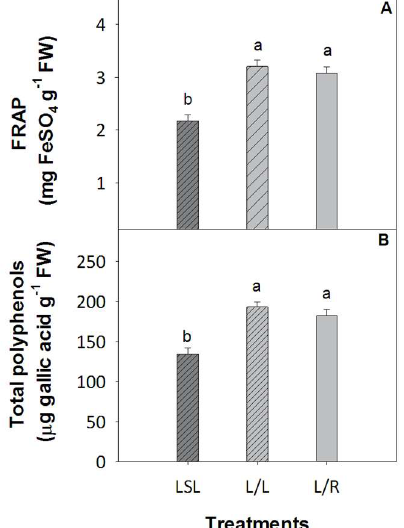
Figure 10. FRAP: Ferric-reducing antioxidant power (mg FeSO4 g − 1 FW) ( A ) and total phenolic compounds (TP, µ g of galic acid g − 1 FW) ( B ) of the fruit produced by treatments LSL (long-shelf-life tomato), L/L (self-grafted Old Limachino tomato) and L/R (grafted Old Limachino tomato on Poncho Negro rootstock) under greenhouse conditions. Each value represents the mean ± SE ( n = 12). Lower-case letters indicate differences ( p ≤ 0.05, Duncan test) among treatments.